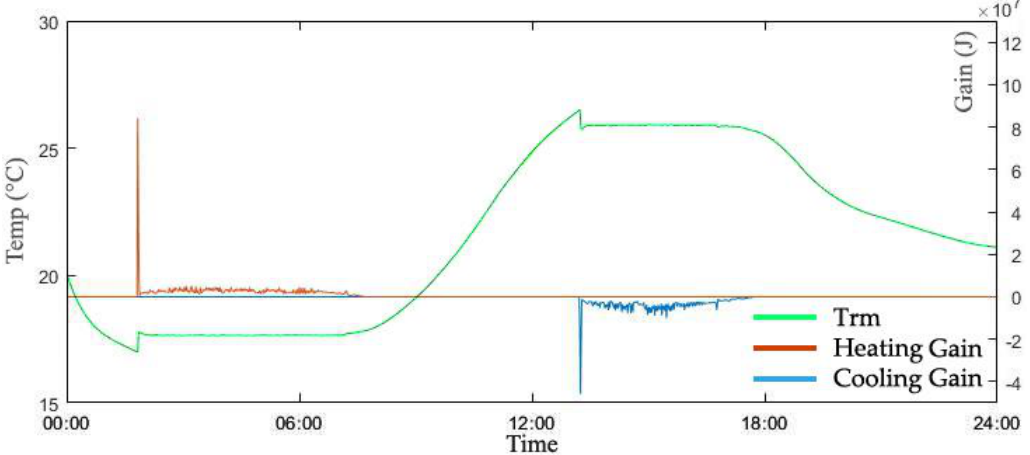
Figure 7. Changes of T rm and energy transfer by the Fuzzy Inference System (FIS) control.